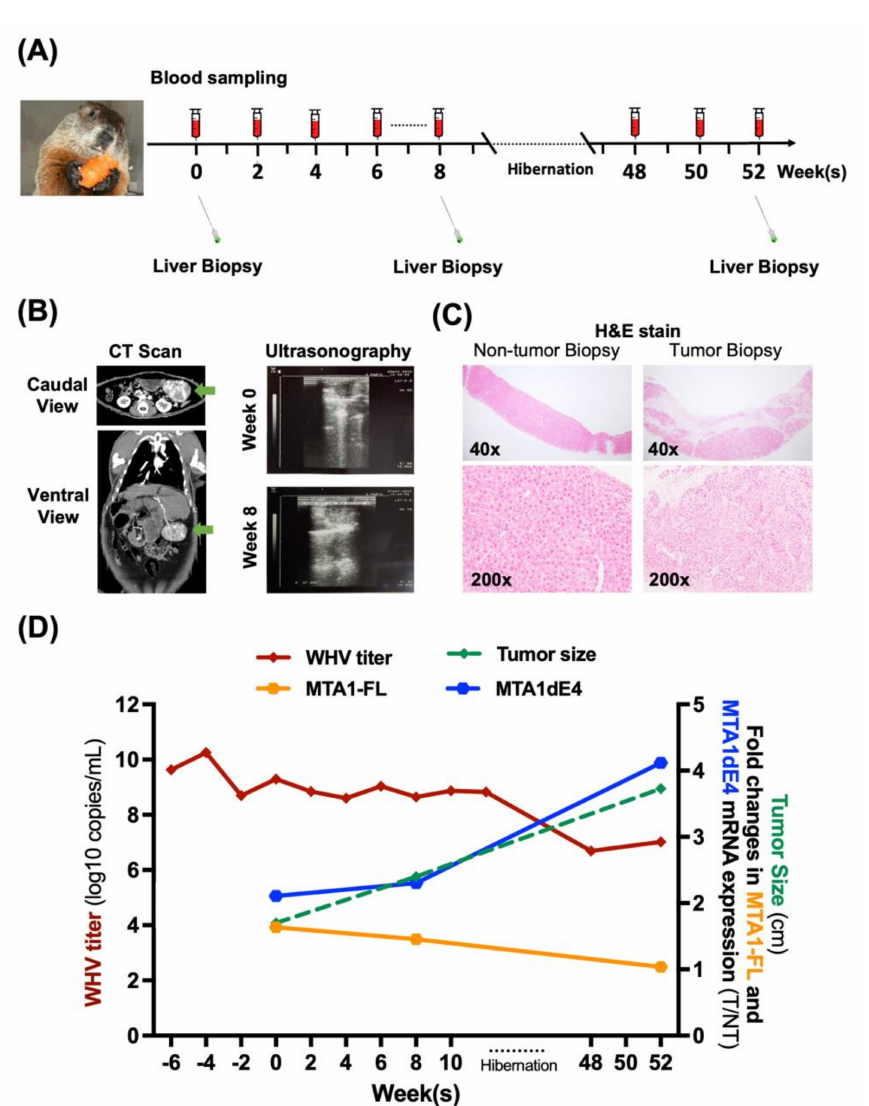
Figure 5. An example for using the woodchuck HCC model to study the complex temporal rela- tionships between MTA1 / MTA1dE4 expression and the progression of chronic liver disease. ( A ) A schematic depicting the experimental procedure of conducting longitudinal monitoring of tumor growth and serial collection of serum and liver samples on a woodchuck HCC model. ( B ) Local- ization of liver tumors by computed tomography (left) and ultrasonography (right). The liver of a woodchuck with one large HCC is indicated by the green arrow. ( C ) Liver biopsies of non-tumor and tumor were stained by the hematoxylin and eosin (H&E) stain and are shown at 40 × and 200 × magnifications. ( D ) Dynamic change of WHV DNA titer, MTA1-FL mRNA, and MTA1dE4 mRNA, as well as tumor size in a chronically WHV-infected and HCC–bearing